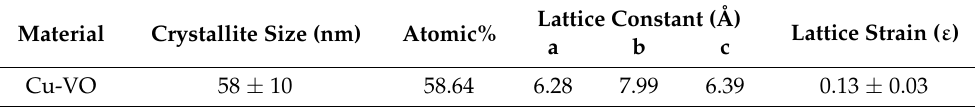
Table 2. Calculated crystallite size, lattice constants, and microstrain values of Cu-VO.